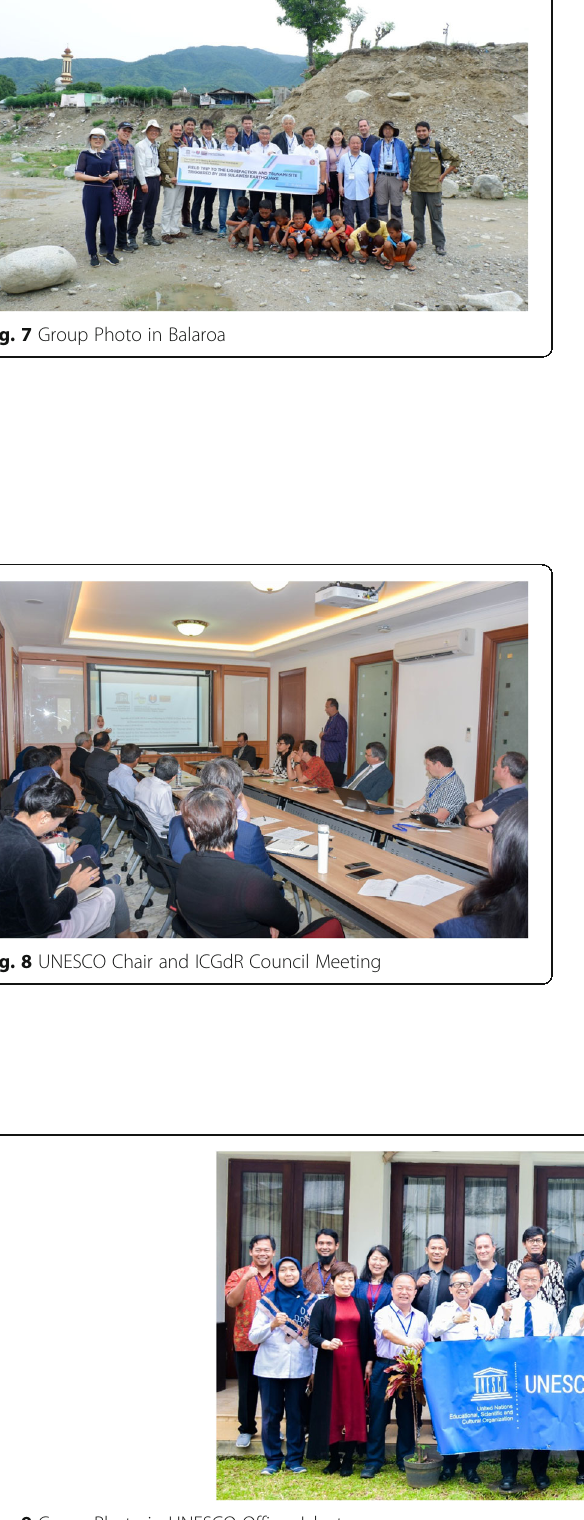
Fig. 9 Group Photo in UNESCO Office,